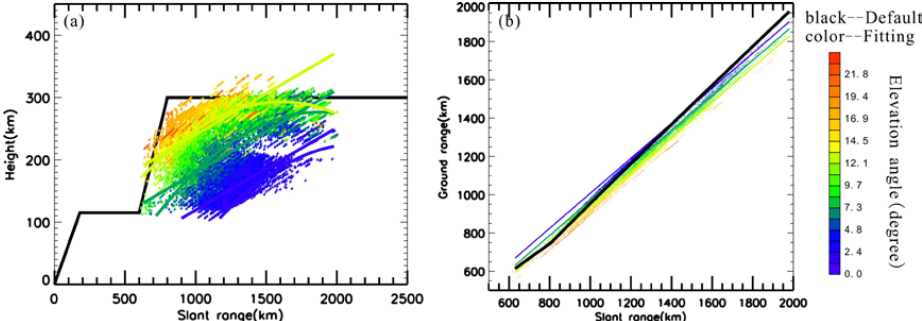
Figure 7 580 Fig. 7. (a) The height model determined by slant range and elevation angle. The color lines represent new height model of linear and quadratic fitting. The black line represents the standard virtual height model of SuperDARN. (b) The ground range model determined by slant range and elevation angle. The color lines represent new model. The black line represents the standard ground range model of SuperDARN shown in Eq. (4). The scatter points are used for fitting. The color bar indicates the elevation angle information.